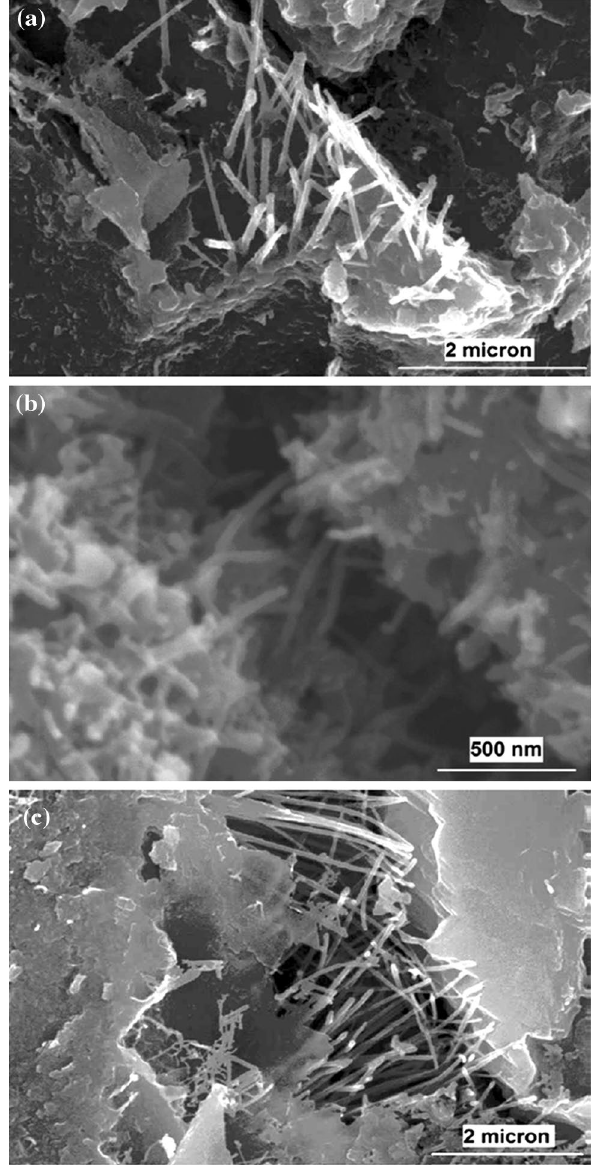
Fig. 12 SEM images of UHPCM reinforced with 0.03 wt.% CNF-OX, showing nano-crack thinning a and nano-crack bridging by CNF b -